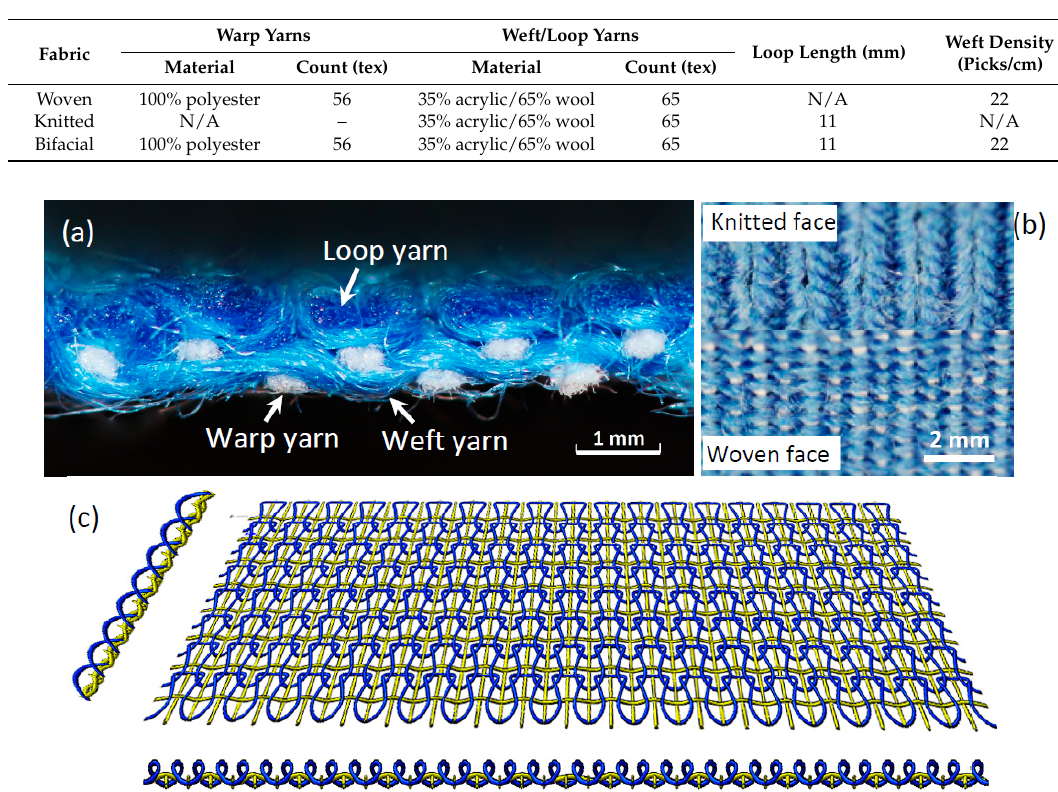
Table 1. The details of the fabric substrates.